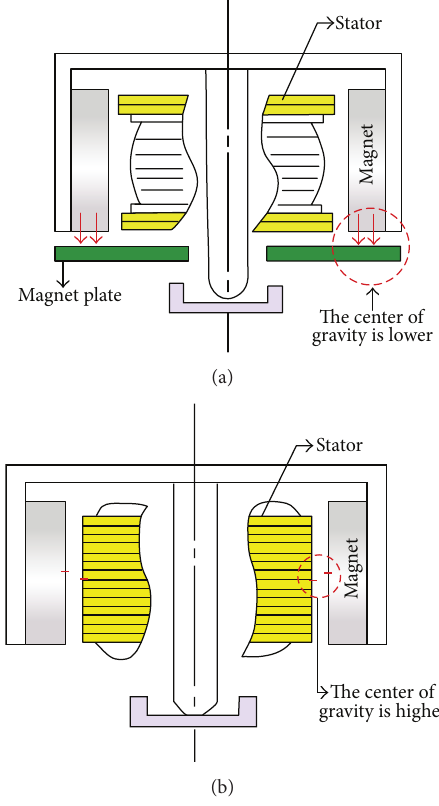
Figure 20: Comparison between maglev fan and traditional